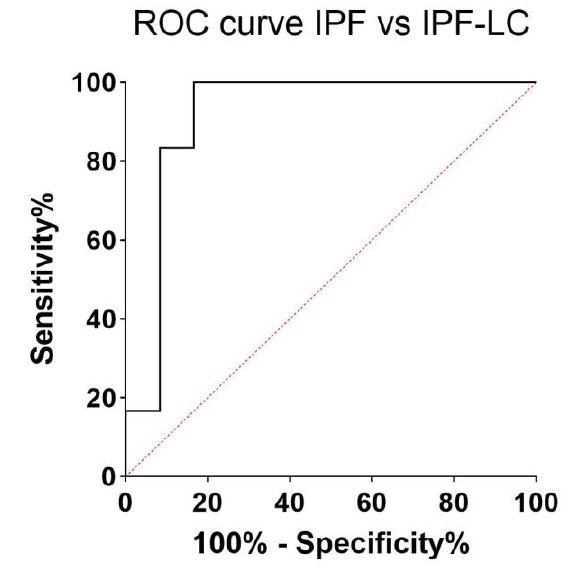
Figure 2. Receiver operating characteristic (ROC) curve analysis distinguished IPF and IPF-LC patients (AUC 92%; 95% CI 78–100; p = 0.0005), indicating a best cut-off value of 1370 U/mL (83% sensitivity, 92% specificity). Table 1. Main characteristics of our study population including age, gender, smoking habit, BMI, LFT parameters, and KL-6 serum concentrations. All data were expressed as median and interquartile range (IQR). Parameters